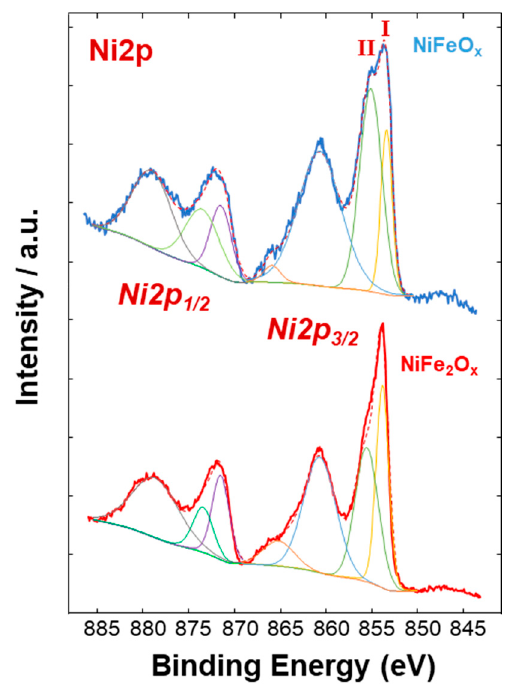
Figure 5. Ni2p XPS signals of the NiFe-oxide catalysts.